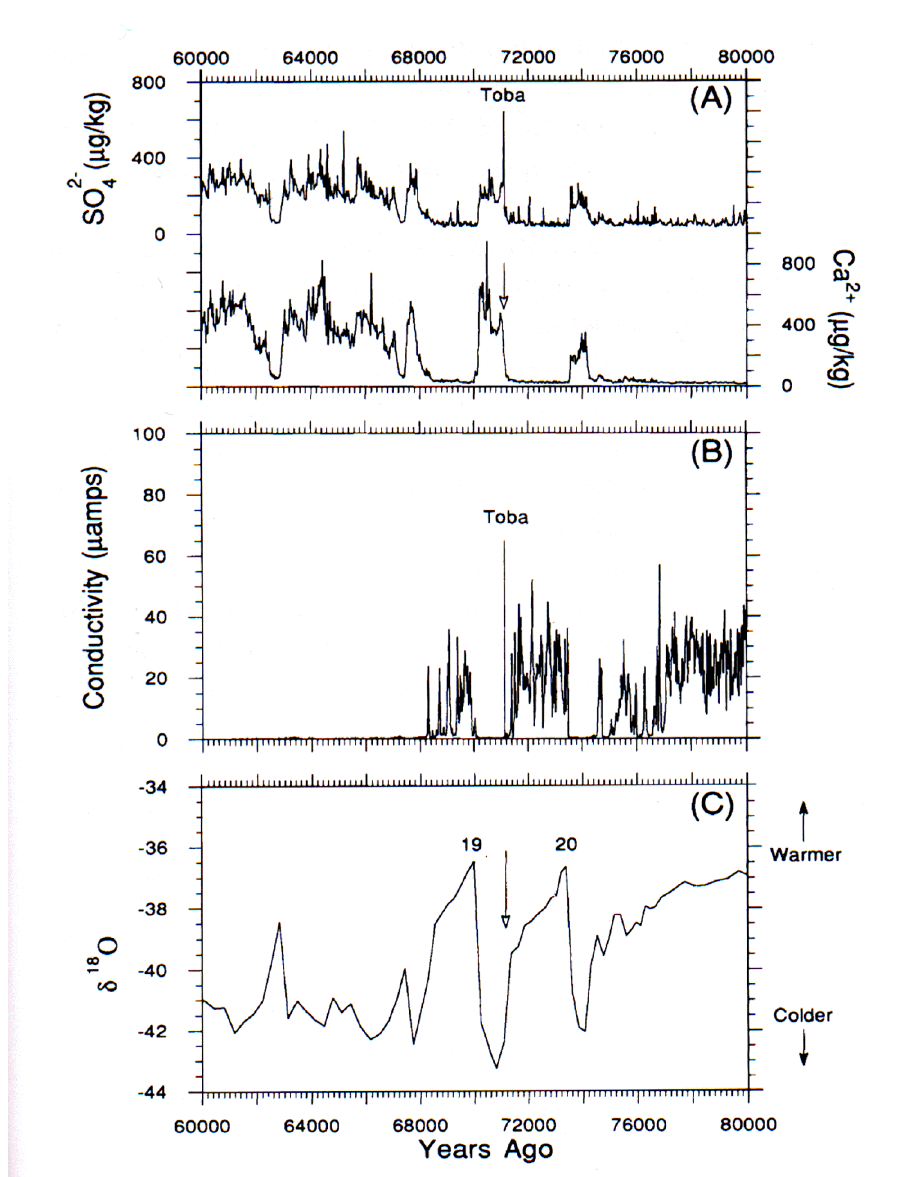
FIGURE 5. Time series of SO 42- (A) and Ca 2+ (A), electrical conductivity (B), and δ 18 O (C) between 60,000 and 80,000 years ago showing the signal associated with the Toba (arrow) mega-eruption in the GISP2 ice core. 19 and 20 represent interstadial (warm) events used as climatic markers in the GISP2 core. A stadial (cold) event separates these interstadial events. The glacial period begins about 68,000 years ago. See text and [61] for details. Reprinted from Quaternary Science Reviews , 19, Use of paleo-records in determining variability within the volcanism-climate system, 417-438, 2000, with permission from Elsevier Science. Initial permission from American Geophysical Union. optical depth ( τ ) of such an eruption would be about 0.1, high enough to cool the Earth(cid:146)s surface. To have a global impact, the eruption must originate in the equatorial region; mid- to high- latitude eruptions will impact only the hemisphere of origin. On the other hand, less explosive eruptions may reach the stratosphere in mid- to high latitudes, particularly during the winter, because of the lower tropopause (8(cid:150)10 km) than that in equatorial regions (15 km). Volcanic eruptions are clearly able to force rapid climatic change (the type of change that has significant impact on humans) and to change climate on decadal to centennial time